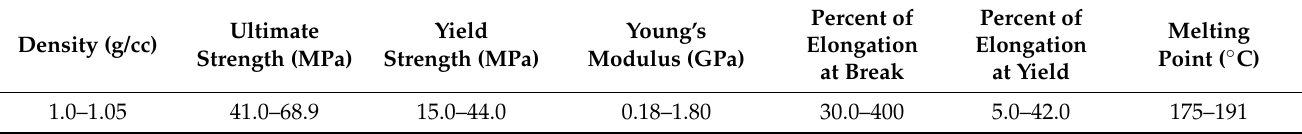
Table 1. Physical and mechanics properties of